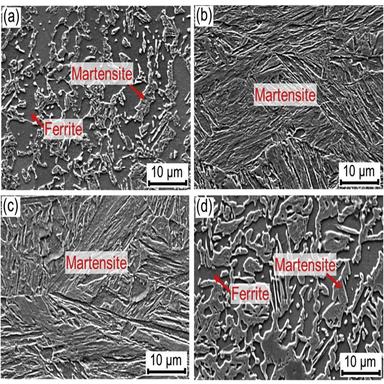
Weld microstructures of the JSC980 steel under 6.5 kA. (a) BM; (b) nugget; (c) UCHAZ; (d) SCHAZ.